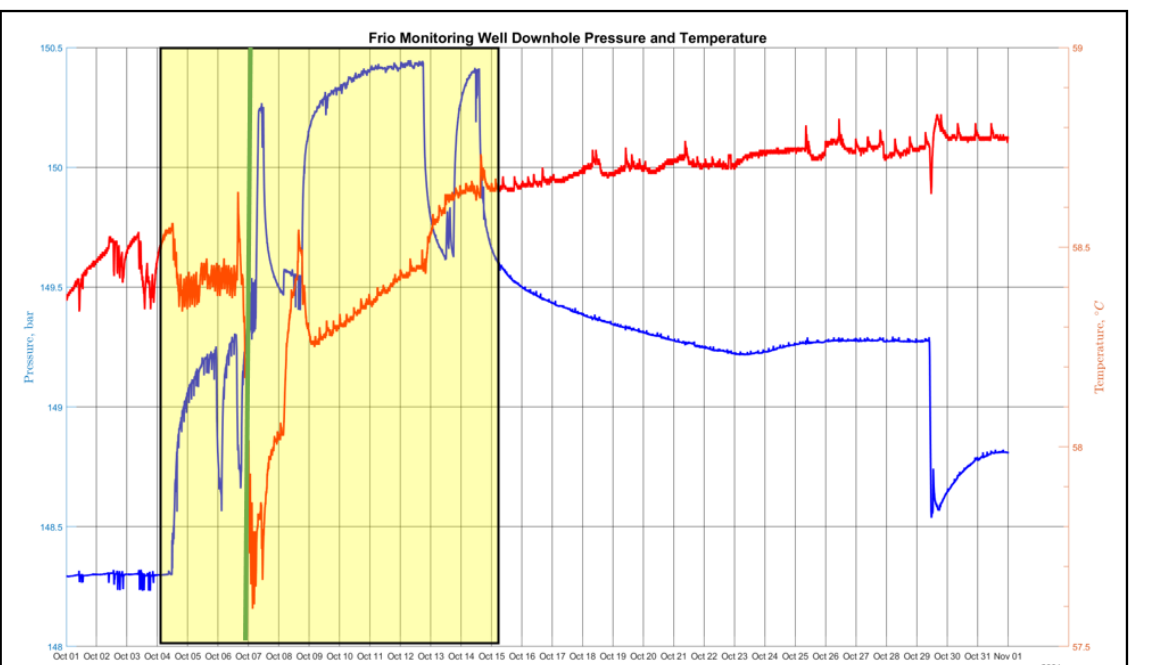
Figure 2. The observation well bottom hole pressure and temperature measurements during the month of October 2004. The injection period is represented by the yellow highlight. The breakthrough time is represented by the green vertical line. Table 2. The model parameters and diffusion coefficient values D computed at T = 65°C using the model of Boudreau [7].